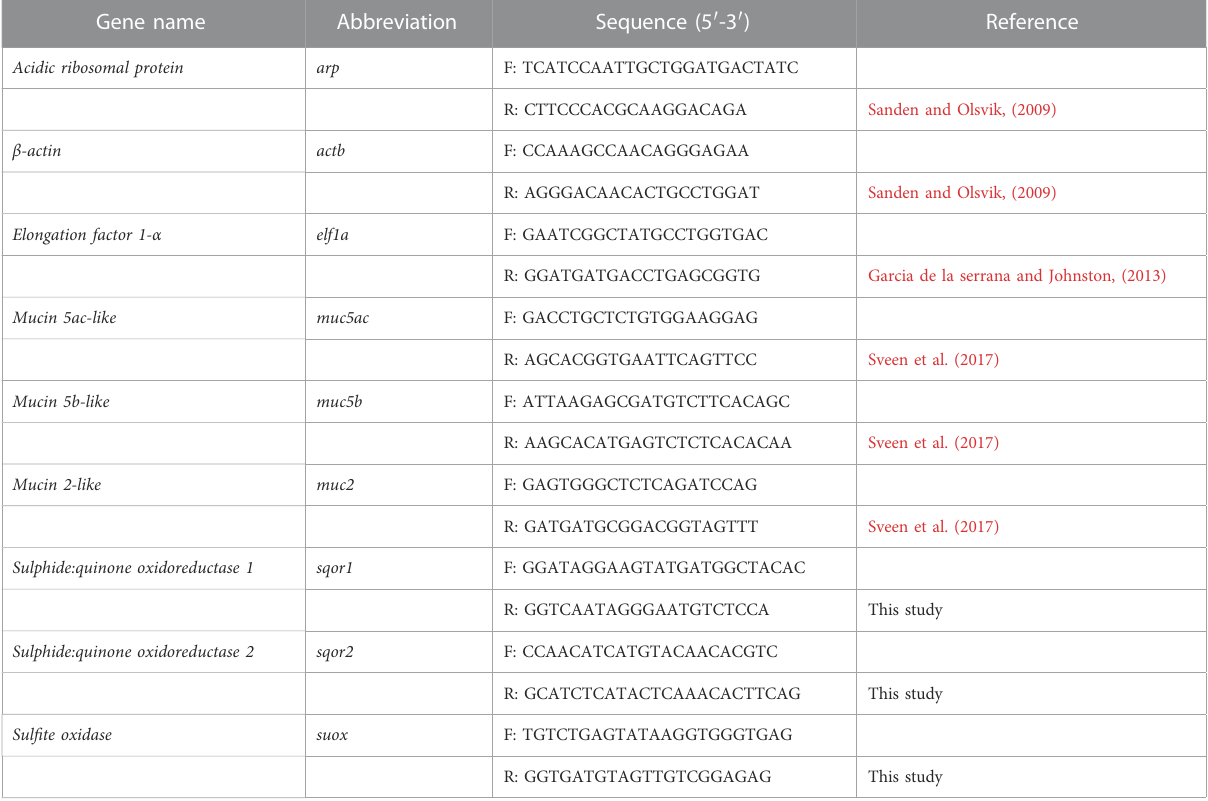
TABLE 1 Target and reference genes used for